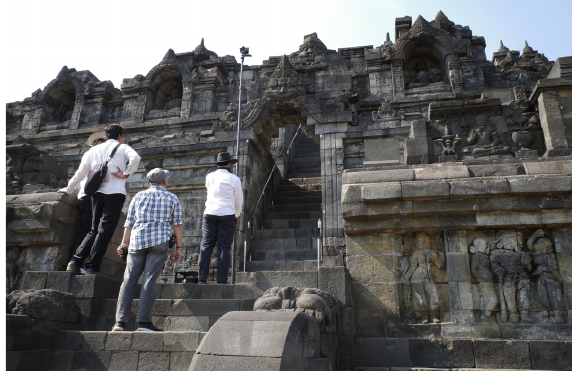
Figure 4. A snapshot photo showing our 3D measurement activity.